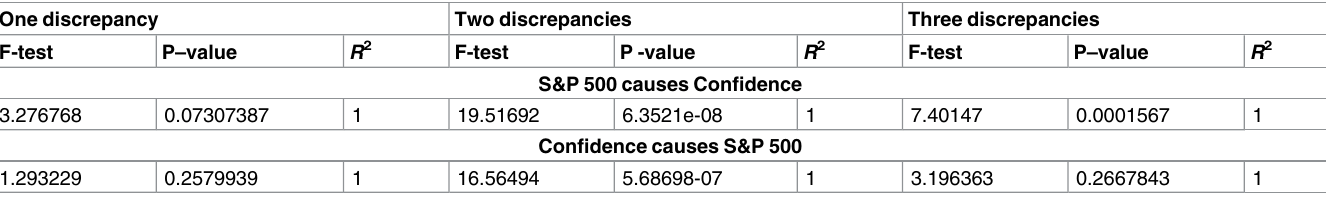
Table 11. Granger test results—causality relationship between the growth rates of the S&P 500 index and its respectiveconfidence index. One